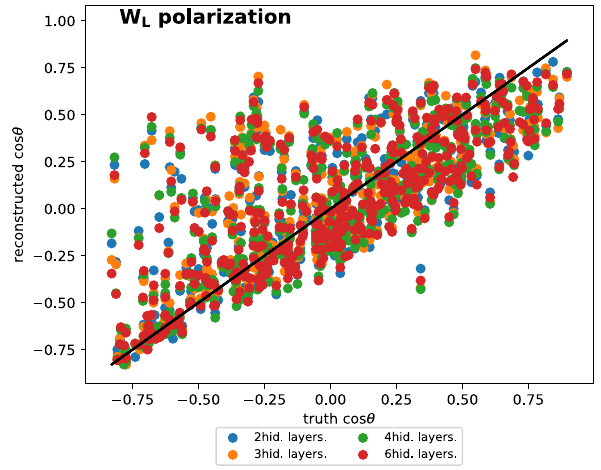
Fig. 13 Scatter plot: generator-level (true) cos ϑ value w.r.t. the recon- structed one in the semi-leptonic channel, using different network topologies